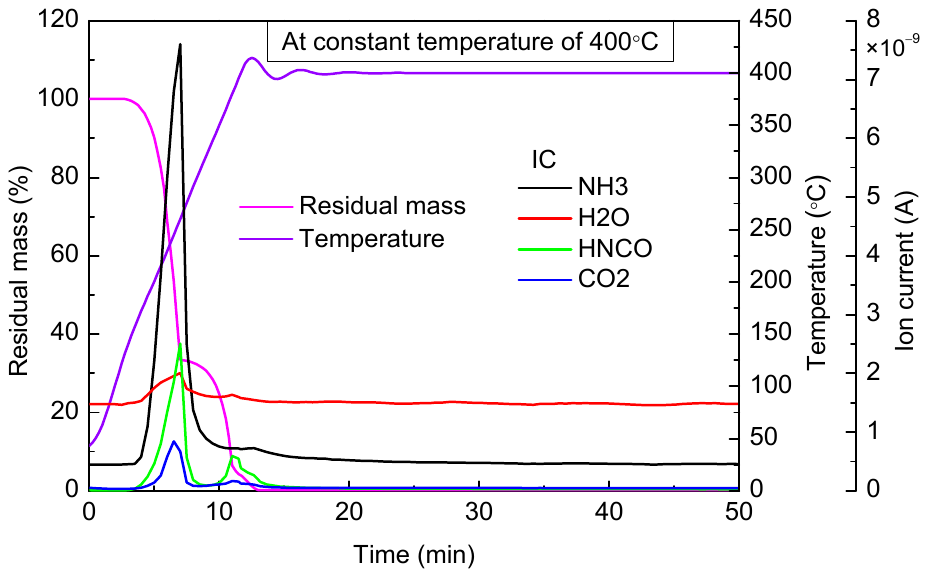
Figure 10. TG-MS results of urea at constant temperature of 400 °C.